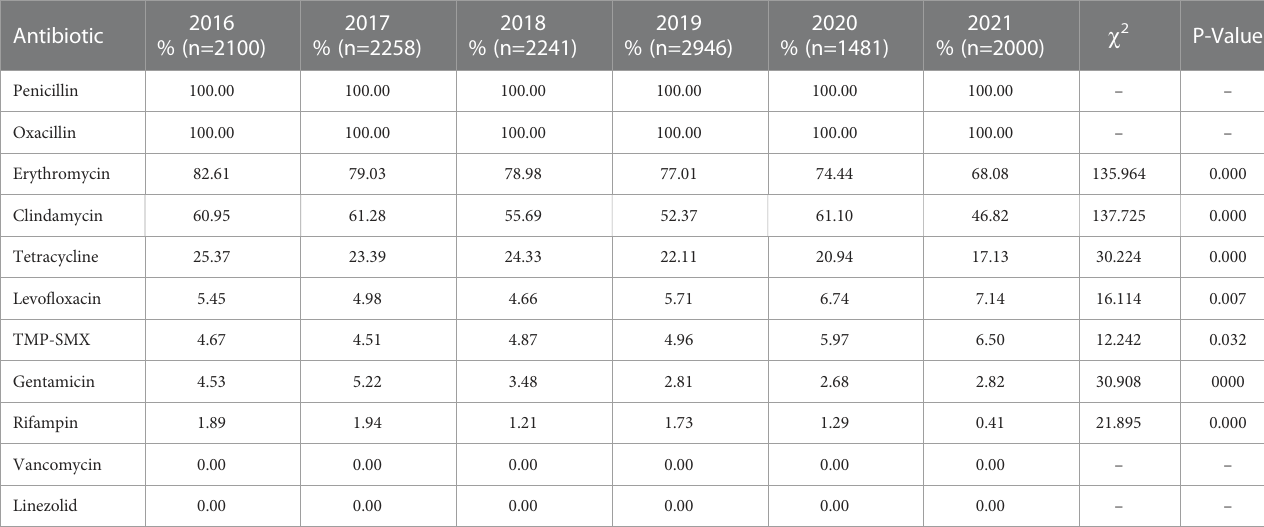
TABLE 3 Antimicrobial resistance rates of MRSA strains in 2016 to 2021.